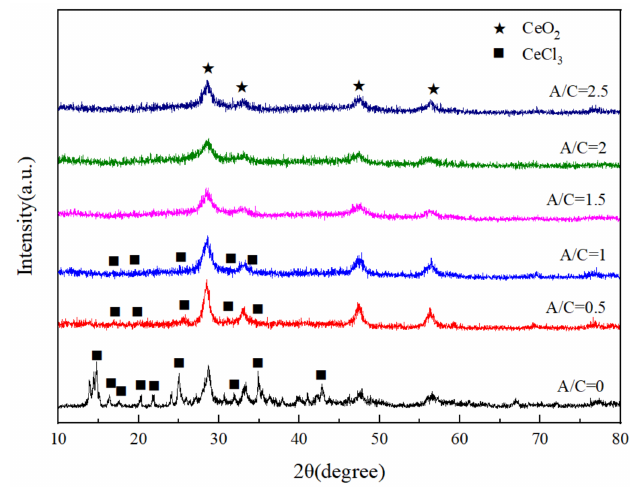
Figure 7. XRD patterns of the pyrolysis products prepared with various (A/C).